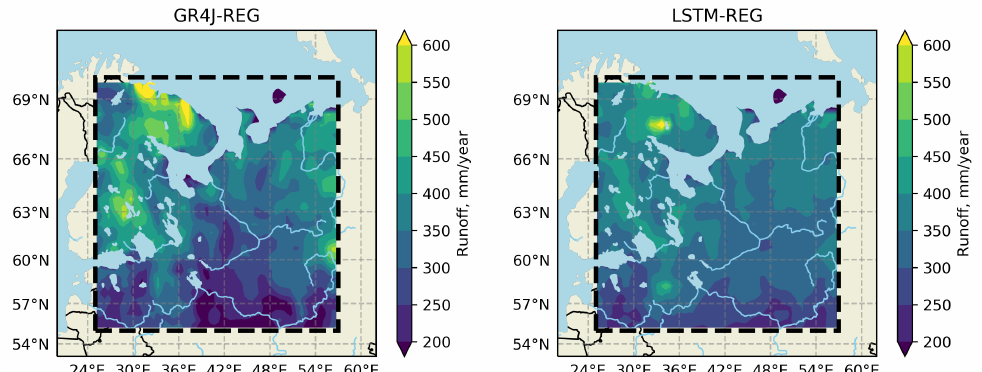
Figure 13. Mean annual runoff estimates for the developed gridded runoff